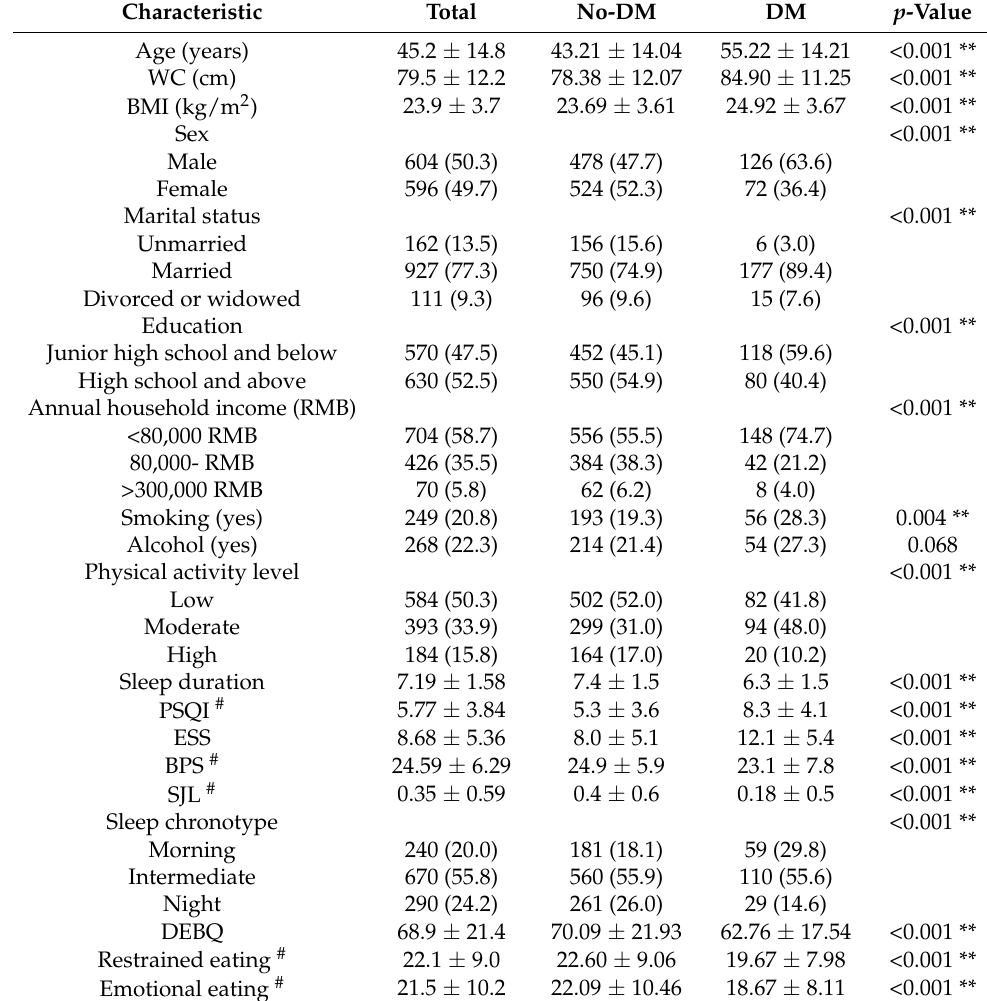
Table 1. Characteristics of